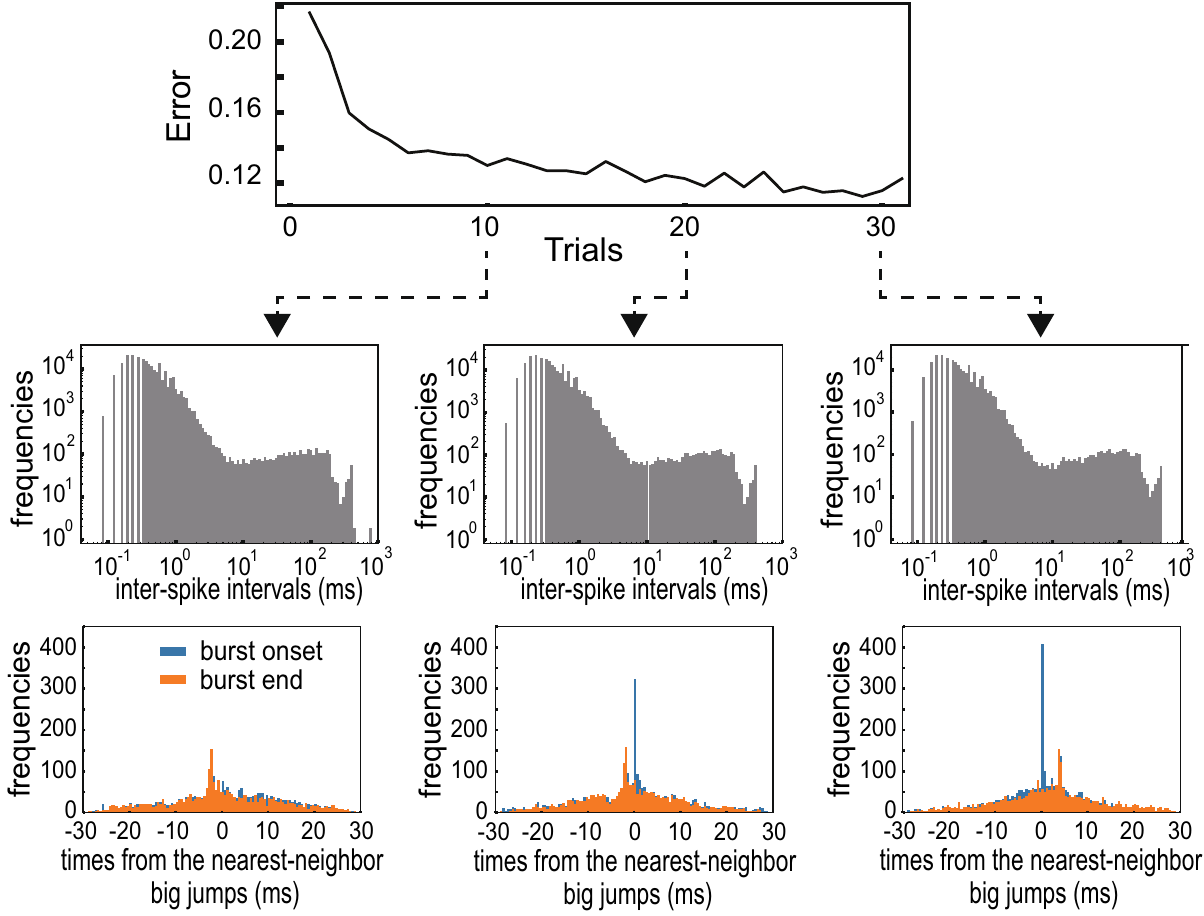
Figure 5. Evolution of synchronous bursting in the RS mode. (top) Learning curve, (middle) the distributions of inter-spike intervals and (bottom) the distributions of burst timing are shown at trials 10, 20 and 30 for the optimally tuned model of the RS